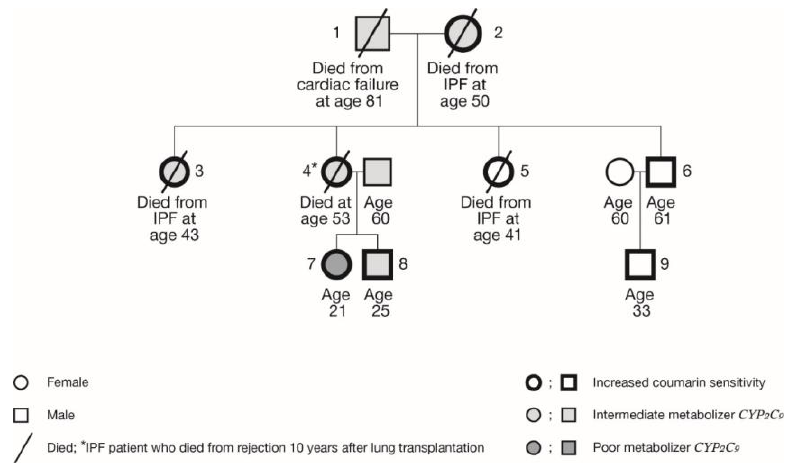
Figure 1. Pedigree of the studied family. Actual genotypes are listed in Table 1.